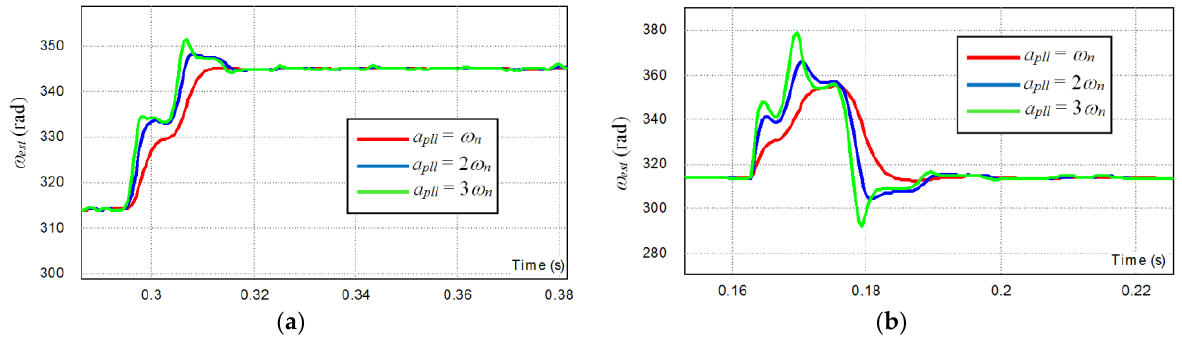
Figure 15. The estimated frequency for ( a ) input signal frequency step variation 31 rad/s, and for ( b ) input signal step phase angle variation 0.5 rad, for the FFPLL in Figure 4, for three different values of PLL parameters a pll and K s = 2, for nominal FFPLL frequency ω n = 314 rad/s and for input signal frequency ω e = 314 rad/s.